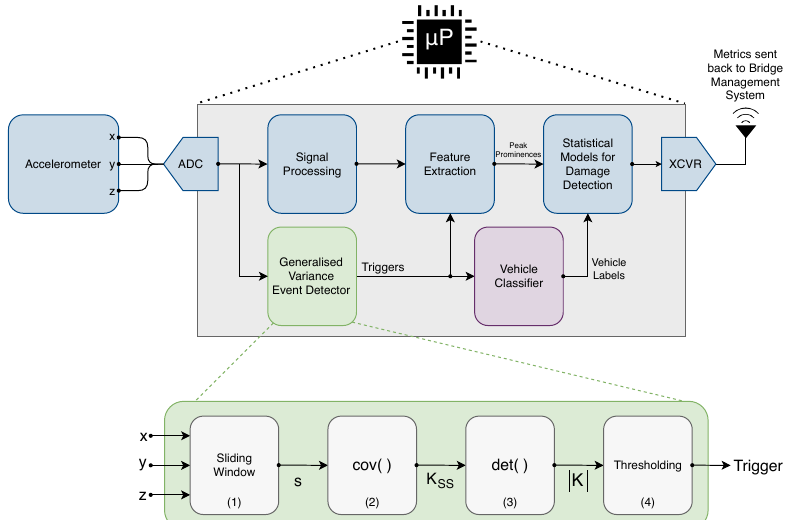
Figure 1. Block diagrams showing the overview of a typical rotation monitoring system (blue) with the added event detector functionality (green) and vehicle classifier